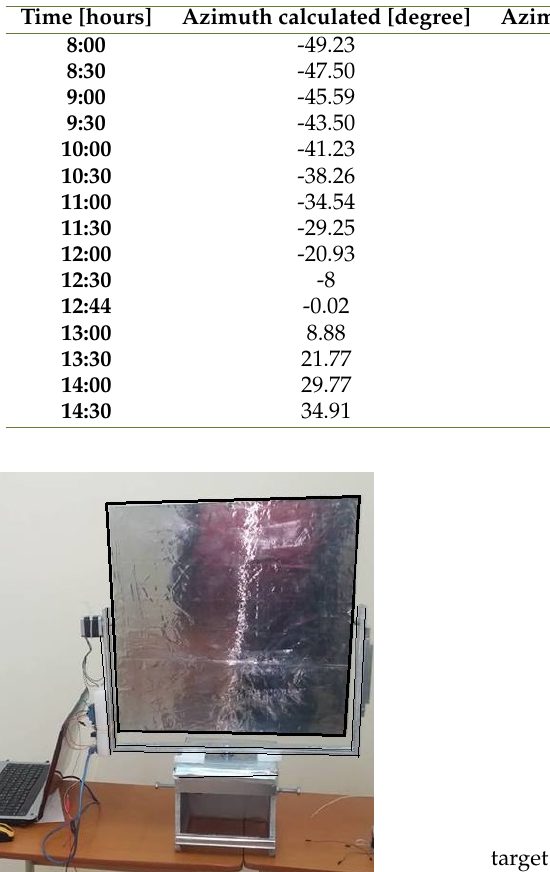
target on the test